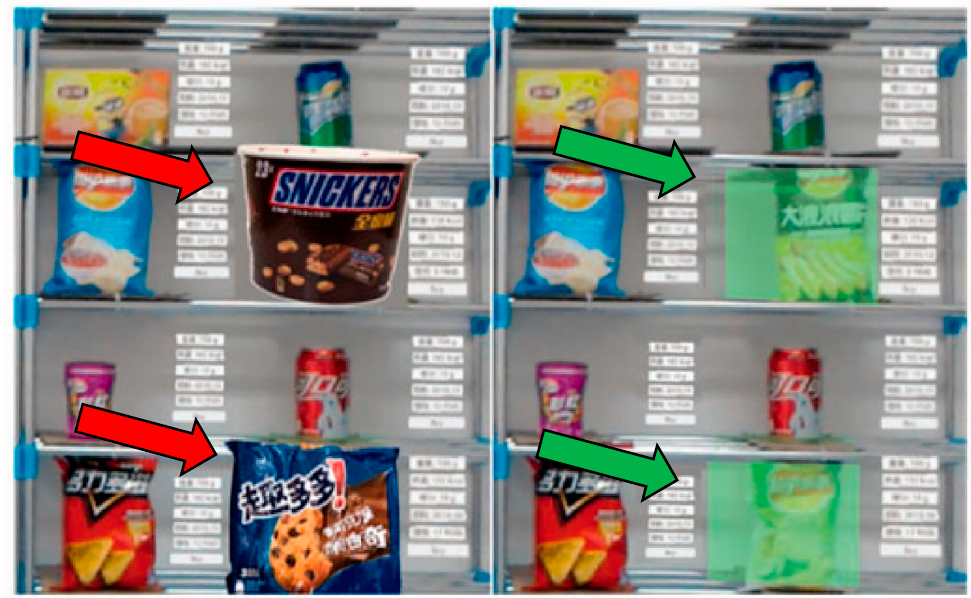
Figure 5. Amplified products are indicated by red arrows ( left ) and highlighted products are indicated by green arrows ( right ). Adapted with permission from [41]. 2022, Taylor & Francis.